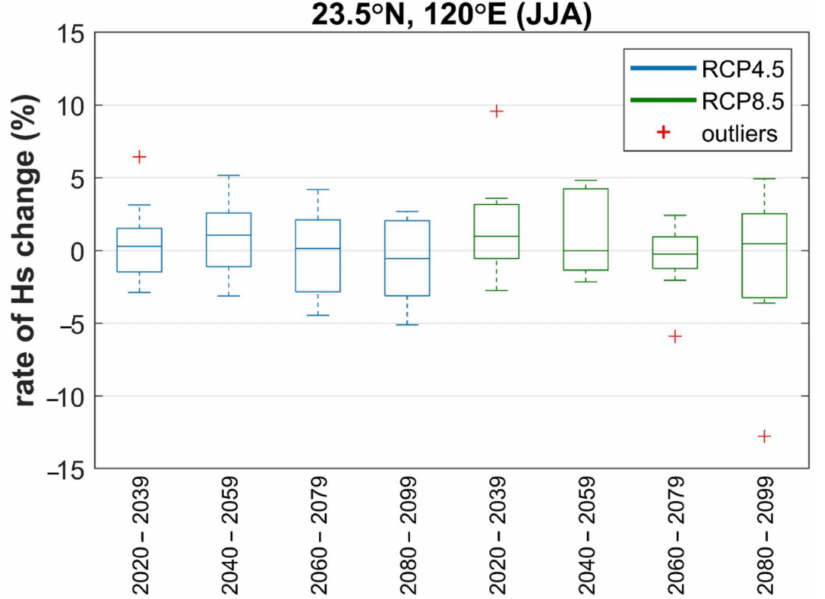
Figure 17. Box plot of rate of change in the seasonal mean of significant wave heights for each GCM, with respect to the reference period from 1980 to 2004 in the region of Taiwan in summer at 23.5 ◦ N, (RCP4.5 and RCP8.5).